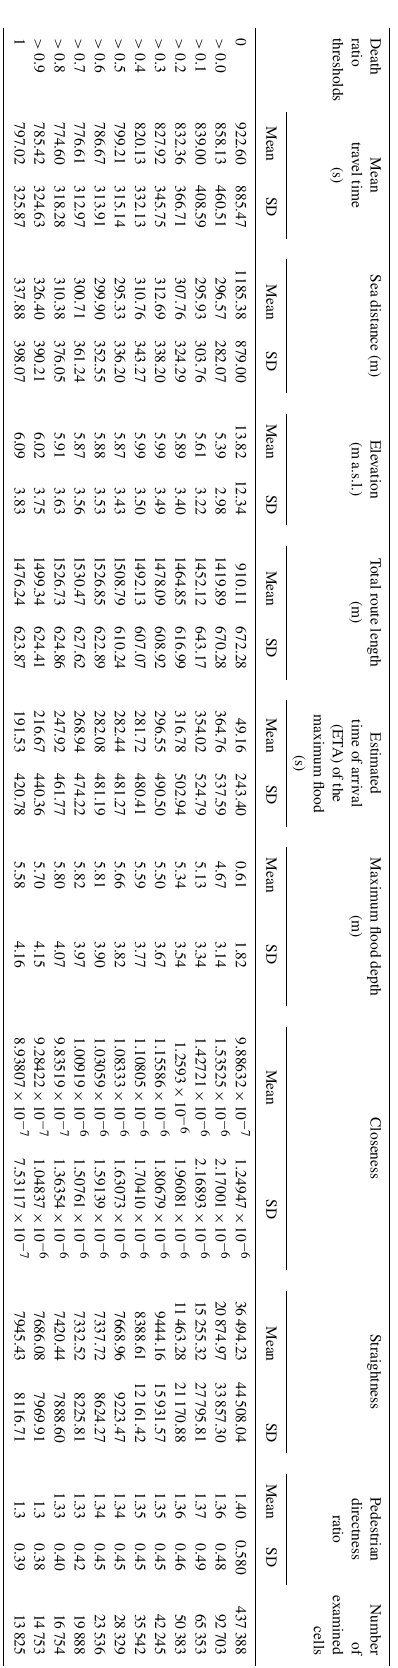
(i.e. with cells 8 × 8, 16 × 16, 32 × 32, 64 × 64 and 128 × 128